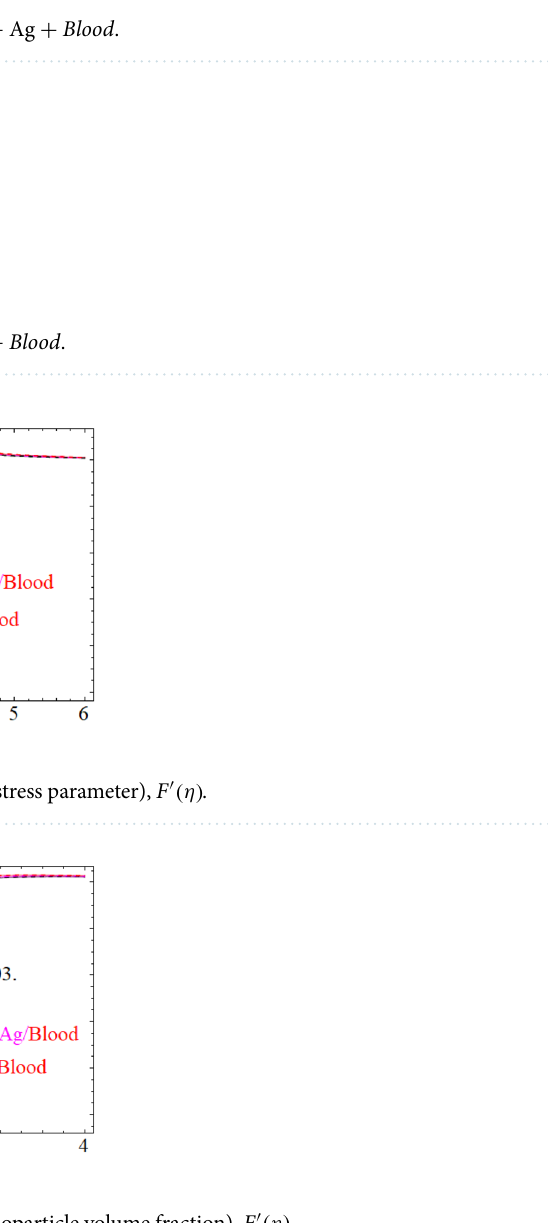
Figure 3. Under the influence of φ 1 , φ 2 (Nanoparticle volume fraction), F ′ (η)